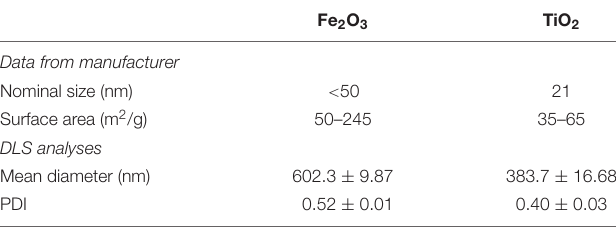
TABLE 1 | Physicochemical properties of Fe 2 O 3 and TiO 2